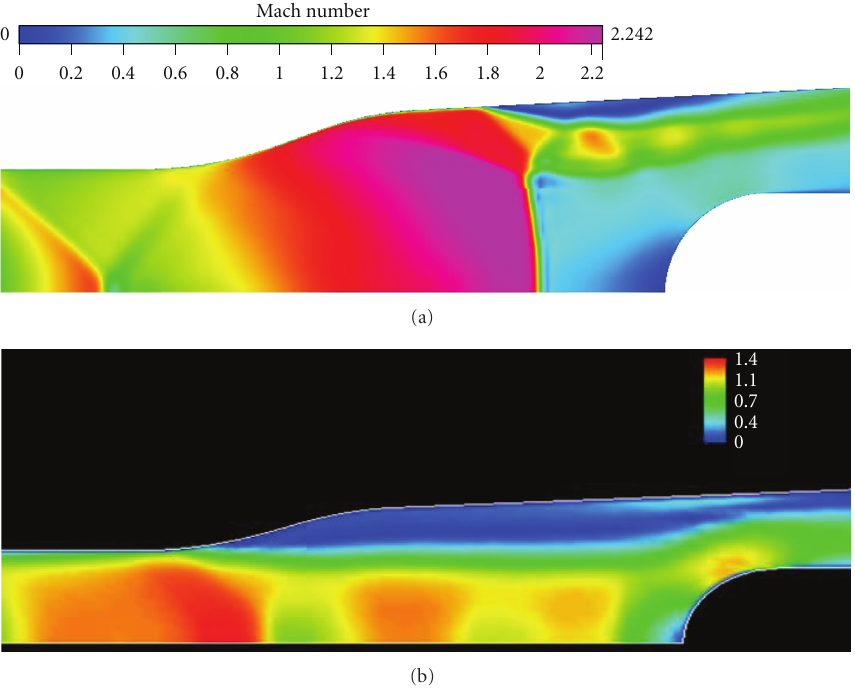
Figure 10: Comparison of simulated Mach number configurations at t = 24 ms with algorithm of (a) SIMPLEC (b) Jameson.